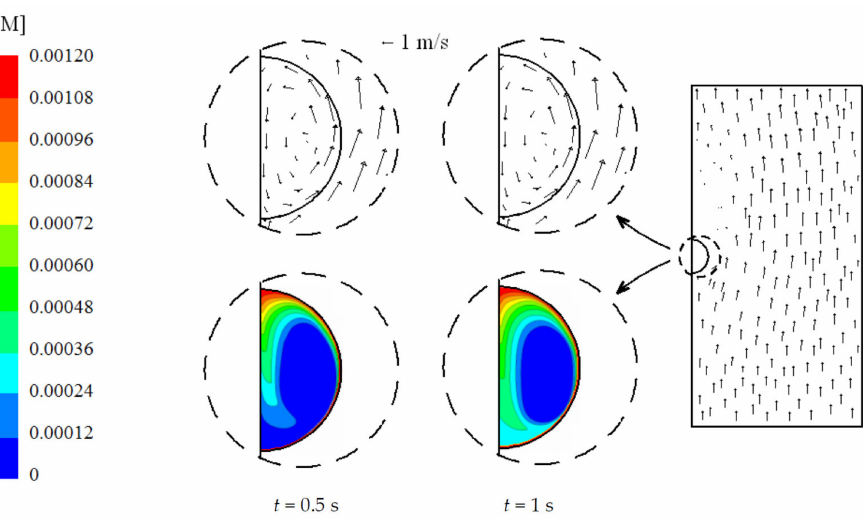
Figure 4. Velocity field and concentration of CO 2 for time (t) 0.5 and 1 s. 5% initial ammonia concentration, 100 ◦ C initial gas temperature, 5 ◦ C initial liquid temperature, and 1000 µ m initial droplet diameter.